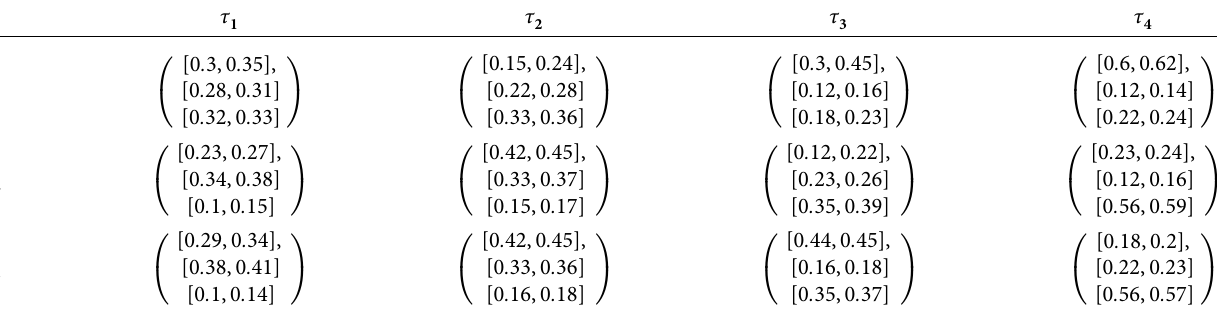
Table 1: Decision matrix of IVPF